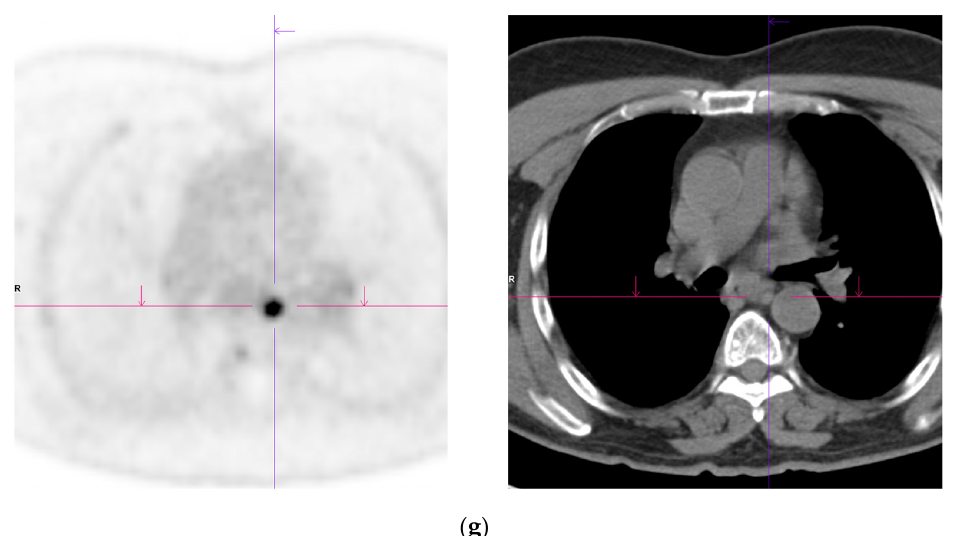
Figure 2. Primary staging. 70 yr old M; PSA 42; Gleason 4 + 5 = 9; MR scan—PIRADS 6 at right apex; PIRADS 4 at left midzone. PSMA PET-CT: 68 Ga-PSMA - 216 MBq; uptake 48 min; BMI = 30.5; Wt 83 Kg. ( a ): Coronal images—focal uptake midline apex anterior SUV = 26.1 with smaller focus SUV-5.4 right midzone; bulky disease in abdominal nodes; metastasis left humerus; left para-aortic node in thorax; bony metastasis left side of S1. ( b , c ): enlarged coronal and transaxial images of left common iliac/para-aortic nodal disease and uptake in apex of gland; transaxial images—node measures 14 mm SUV = 40.1; X-hairs show location. ( d , e ): enlarged coronal and transaxial images of right pelvic nodal that measures 1.4 mm SUV = 5.1; uptake in right midzone and apex as well as disease in left midzone of gland; X-hairs show location. ( f , g ): enlarged coronal images of para-aortic/para-oesoph- ageal nodal disease in mediastinum; node measures 5.5 mm, SUV = 17.2; X-hairs show location.